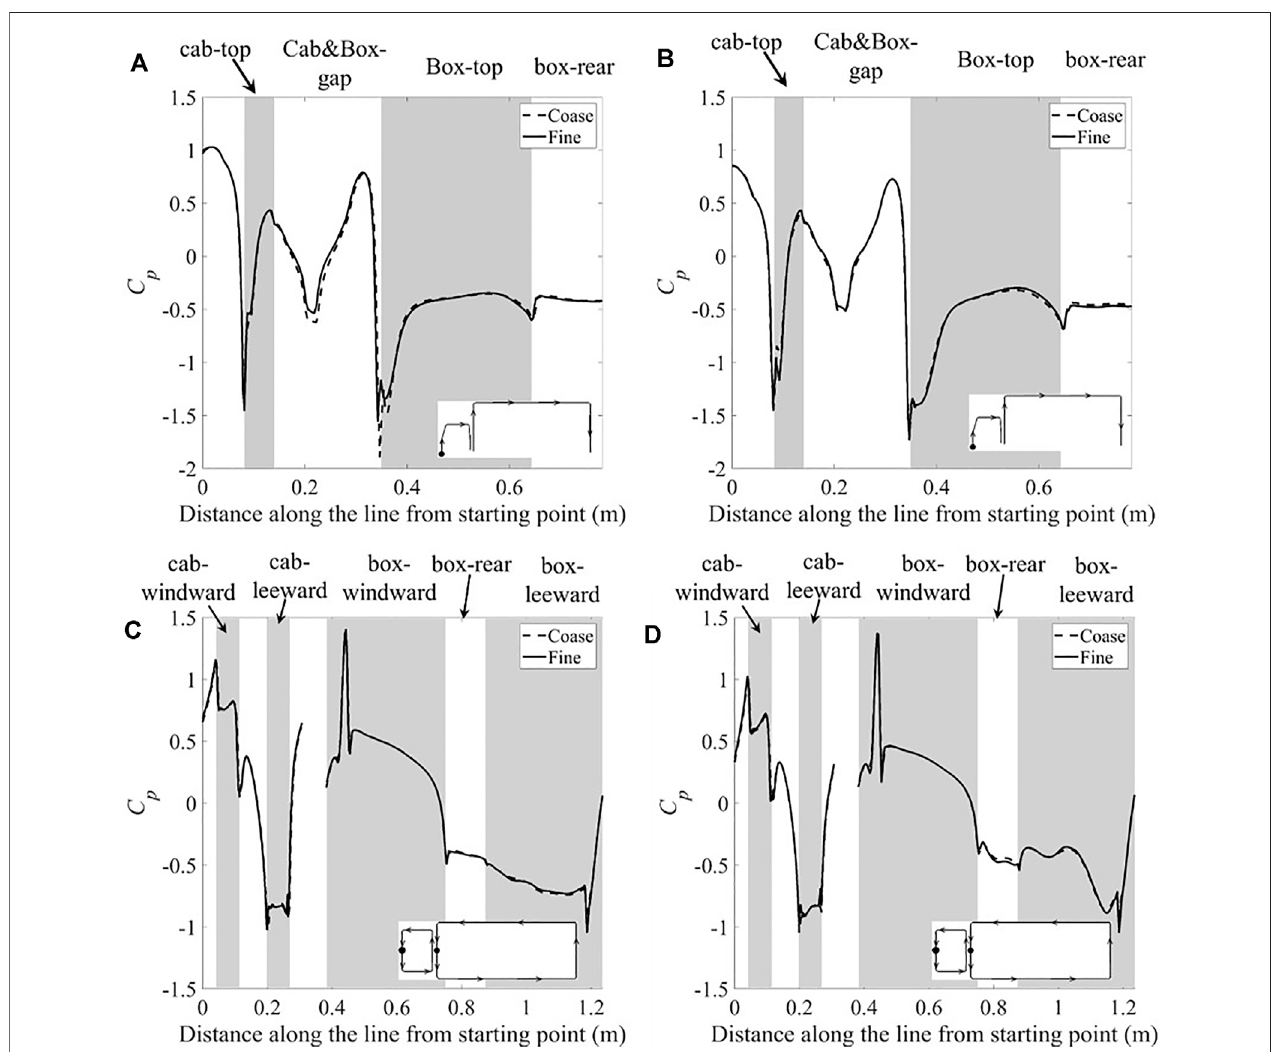
FIGURE3| Surfacepressurecoef fi cientalongtwocross-sectionallinesontwoofthelorriesintheplatoonforcoarseand fi nemeshes: (A) .Lorryone at y/L=0; (B) . Lorry eight at y/L = 0; (C) . Lorry one at z/L ≈ 0.57; (D) . Lorry eight at z/L ≈ 0.57.